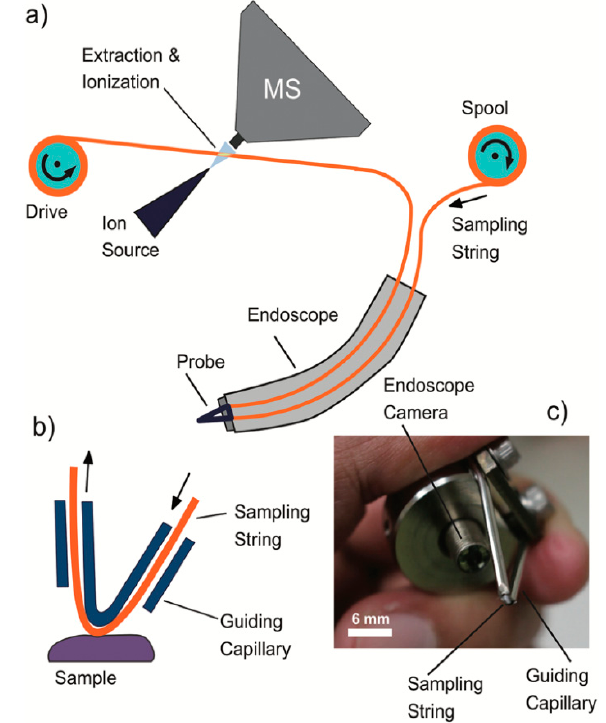
Figure 6. ( a ) Simplified schematic of the endoscopic mass spectrometry system that uses a moving string as the sampling and transportation material. ( b ) Configuration of the sampling probe. The sample is wiped off from the surface by the moving string and carried to the extraction and ionization region near the mass spectrometry (MS) inlet. ( c ) Photograph of the probe tip. Reproduced from [84], with permission from RSC Publishing, 2019.